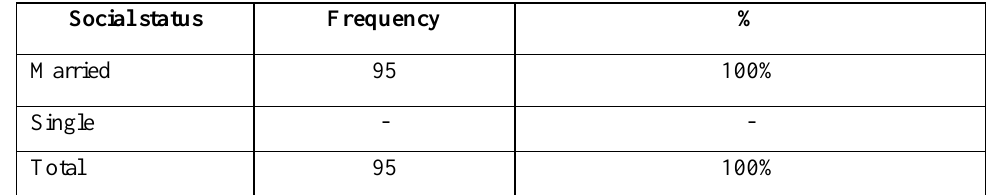
Table 3. Prevalence of patients with Trichomonas vaginalis according to social